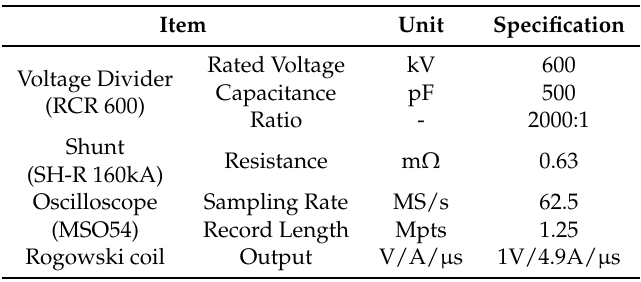
Table 4. Specifications of measurement sensors.